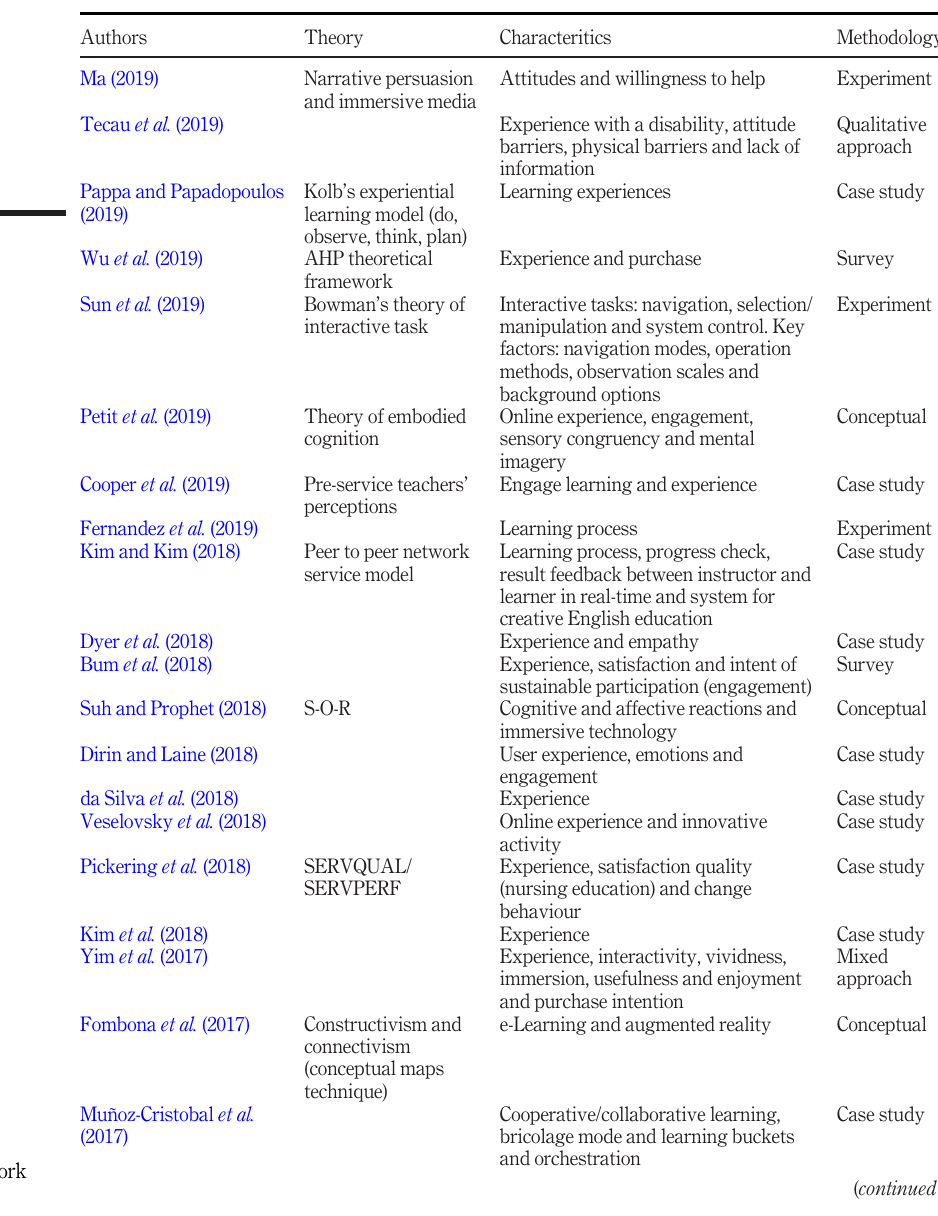
Table 2. TCM framework